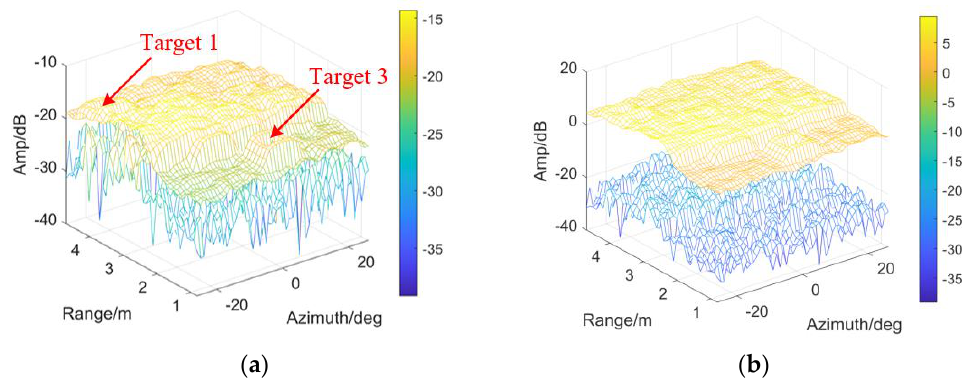
Figure 12. The outputs of CA-CM-CFAR by employing ( a ) Student-t test statistics; ( b ) Gaussian test